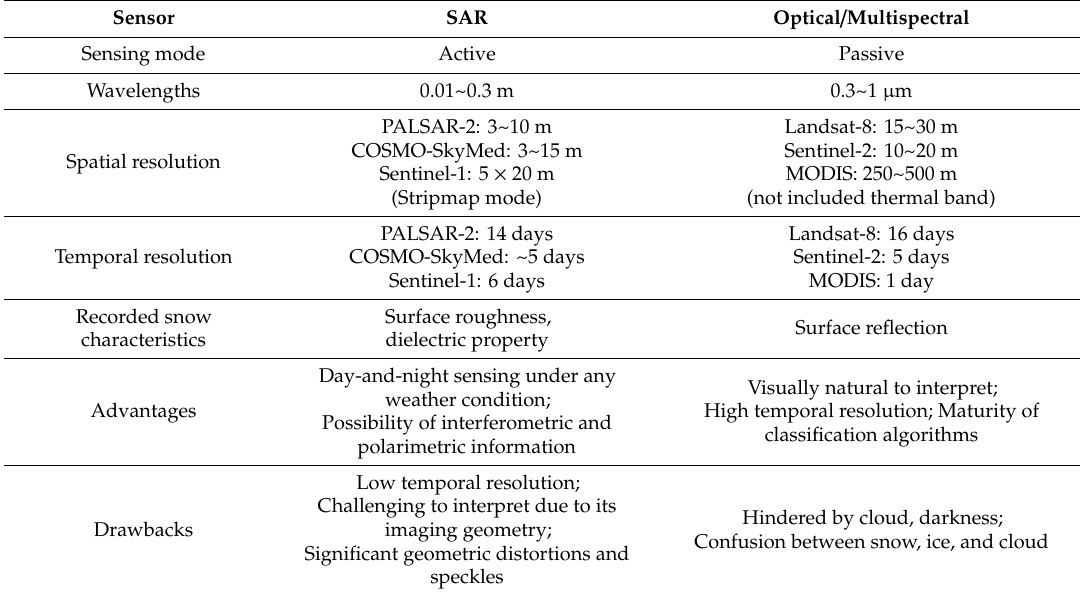
Table 1. Comparison of SAR and optical / multispectral sensors regarding their ability to detect snow